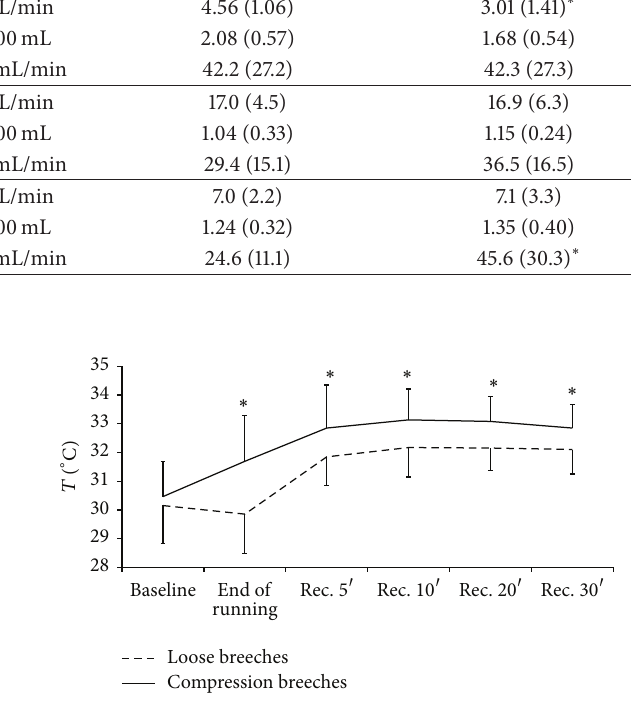
Figure 1: Changes in calf skin temperature (the area covered with the garments) when wearing loose and compression experimental breeches. ∗ is indicative of a significant difference at the time point between the conditions ( 𝑃 < 0.05 ). Rec. 5 󸀠 to 30 󸀠 stand for recovery up to 30 minutes after the running